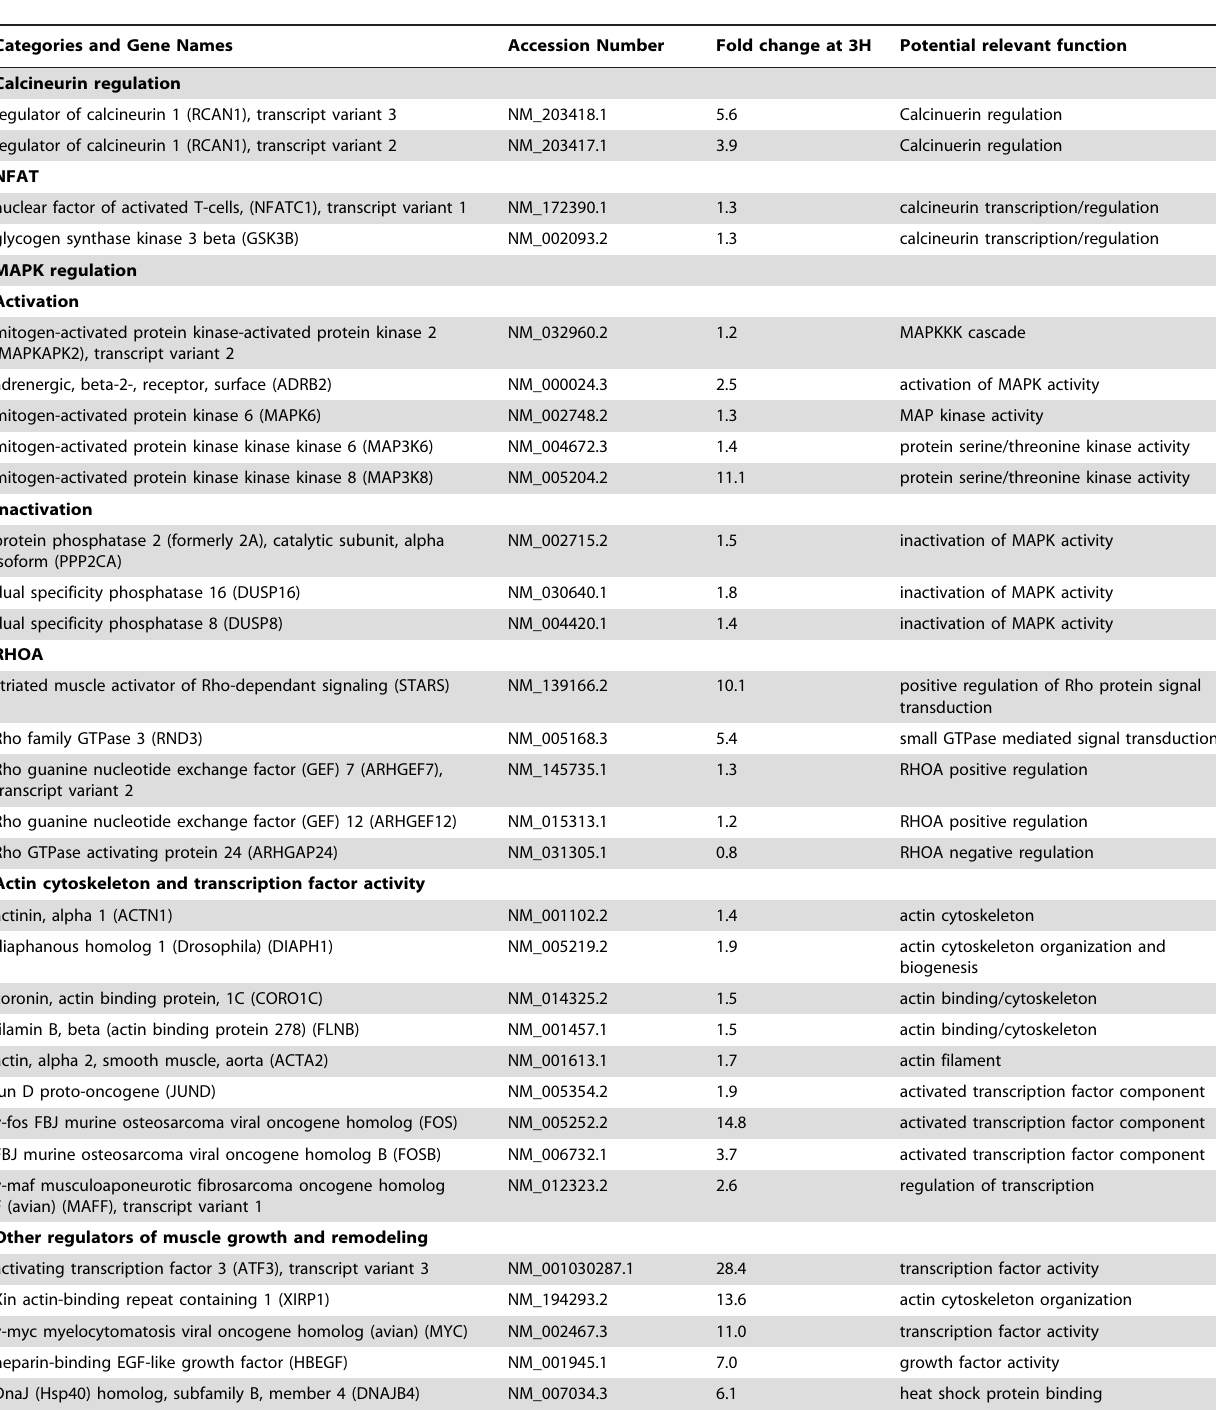
Table 5. Fold change of gene expression after 3 hours of recovery from eccentric exercise using DNA microarray analysis (n